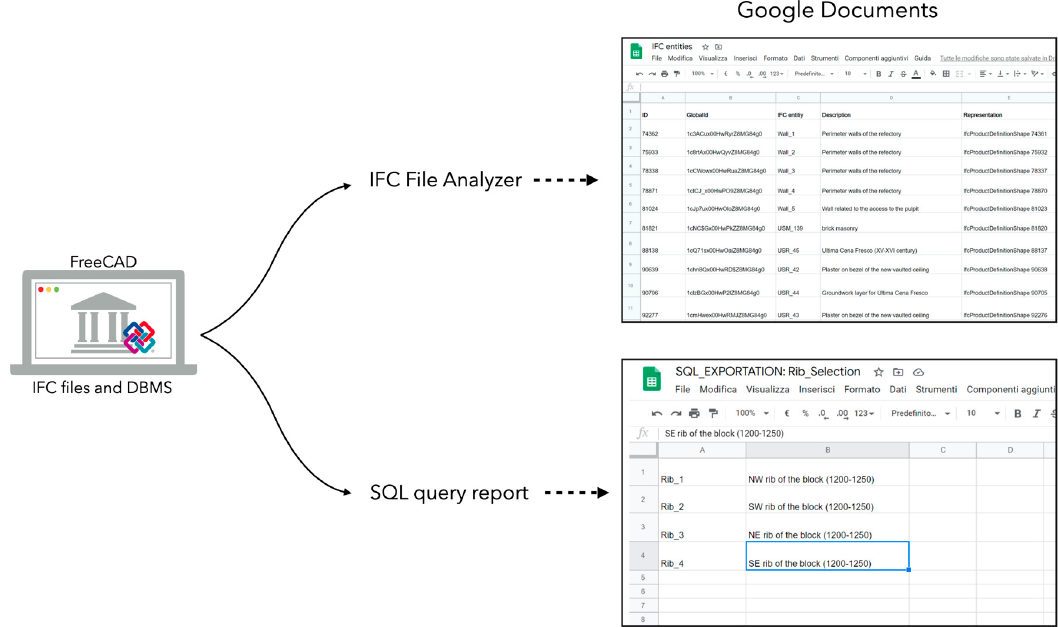
Figure 20. Example of exportable datasheets from IFC File Analyzer and SQL query report derived from IFC files and DBMS of FreeCAD software.